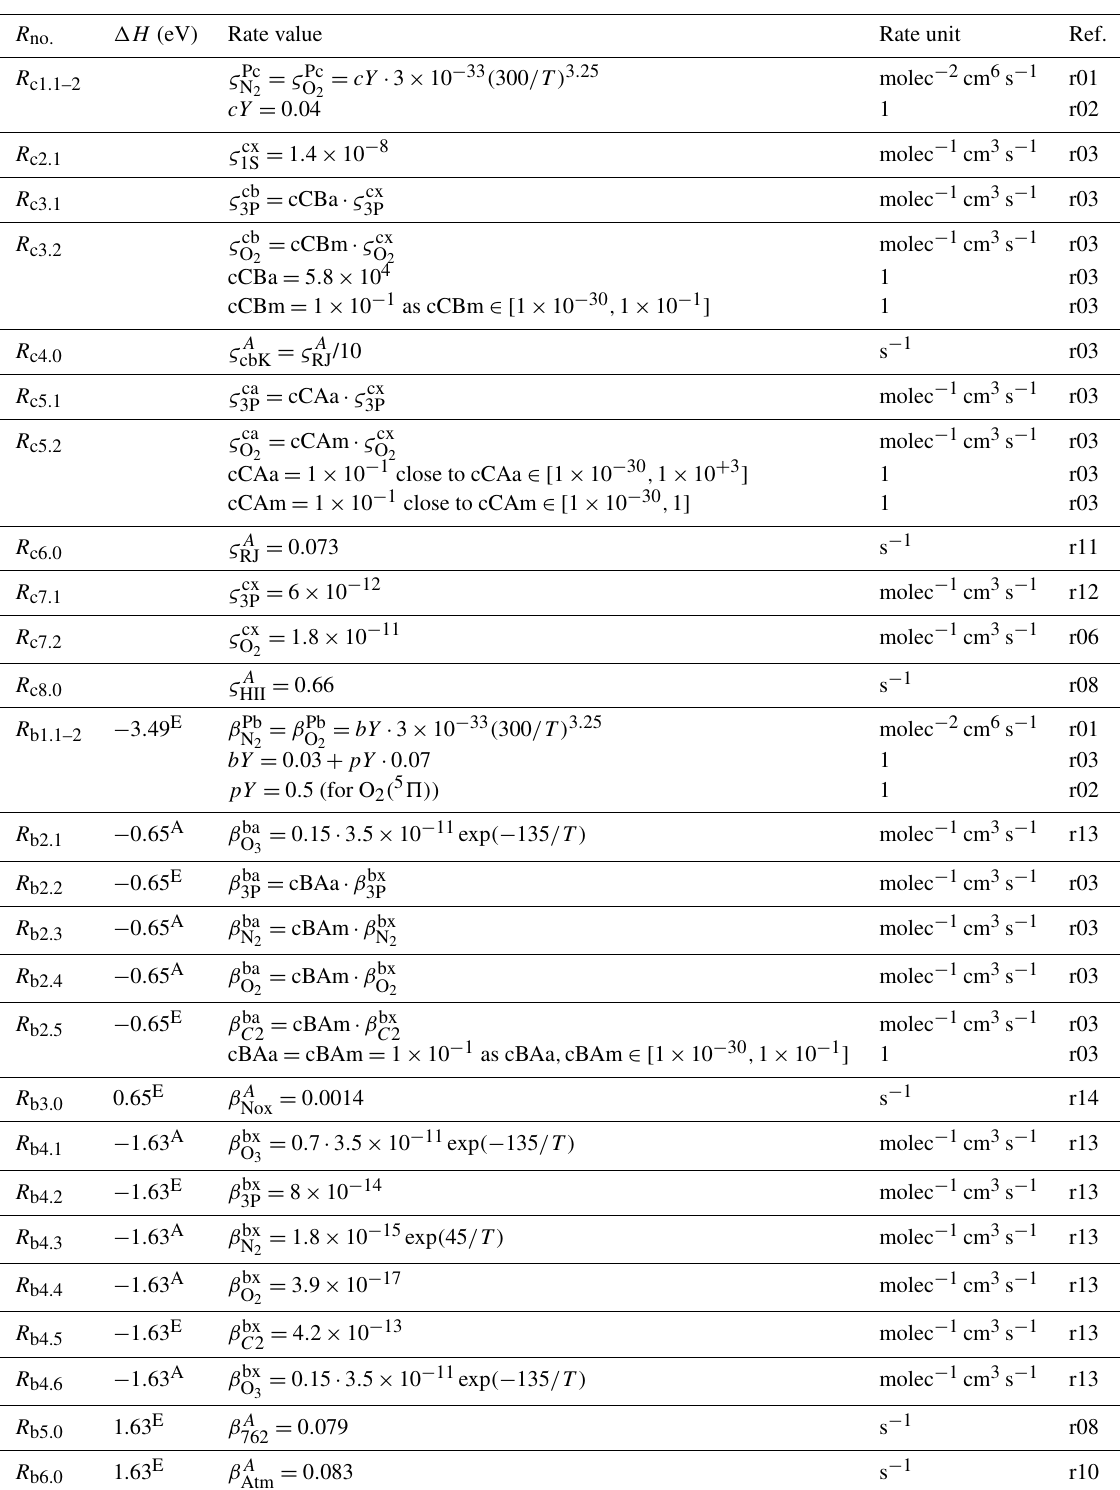
Table 9. Rate values of the processes listed in Table 6. References: r10 – Predoi-Cross et al. (2008), r11 – Slanger (1978), r12 – Kenner and Ogryzlo (1983), r13 – Burkholder et al. (2015), r14 – Minaev and Ågren (1997). The labels r01, r02, r03, r06 and r08 were used in Table 8. The enthalpy change ( (cid:49)H ) was determined at standard temperature and pressure; see Table 11 for abbreviations. R no